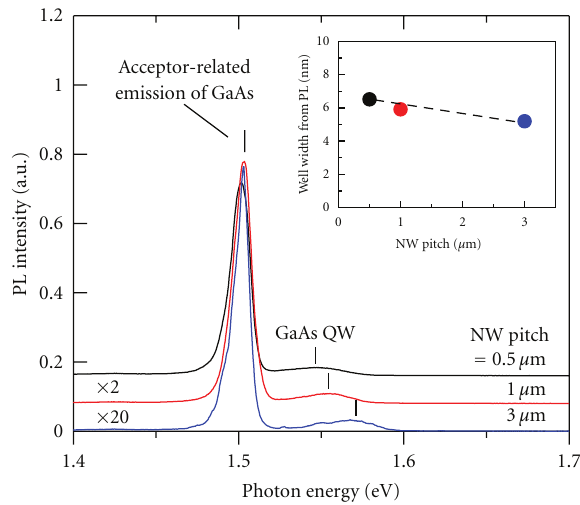
Figure 11: Dependence of PL spectra on NW pitch for heterostruc- ture NWs containing GaAs QW. Graph in insert indicates GaAs QW width as function of NW pitch